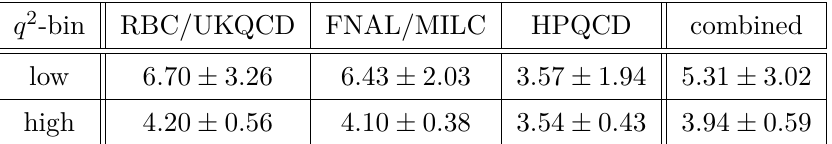
Table 4 . Values of | V ub | · 10 3 extracted from the B s → K‘ν ‘ decays measured at LHCb in the low ( q 2 ≤ 7 GeV 2 ) and high ( q 2 ≥ 7 GeV 2 ) q 2 -bins using the DM bands for the theoretical FFs. in two different q 2 -bins,